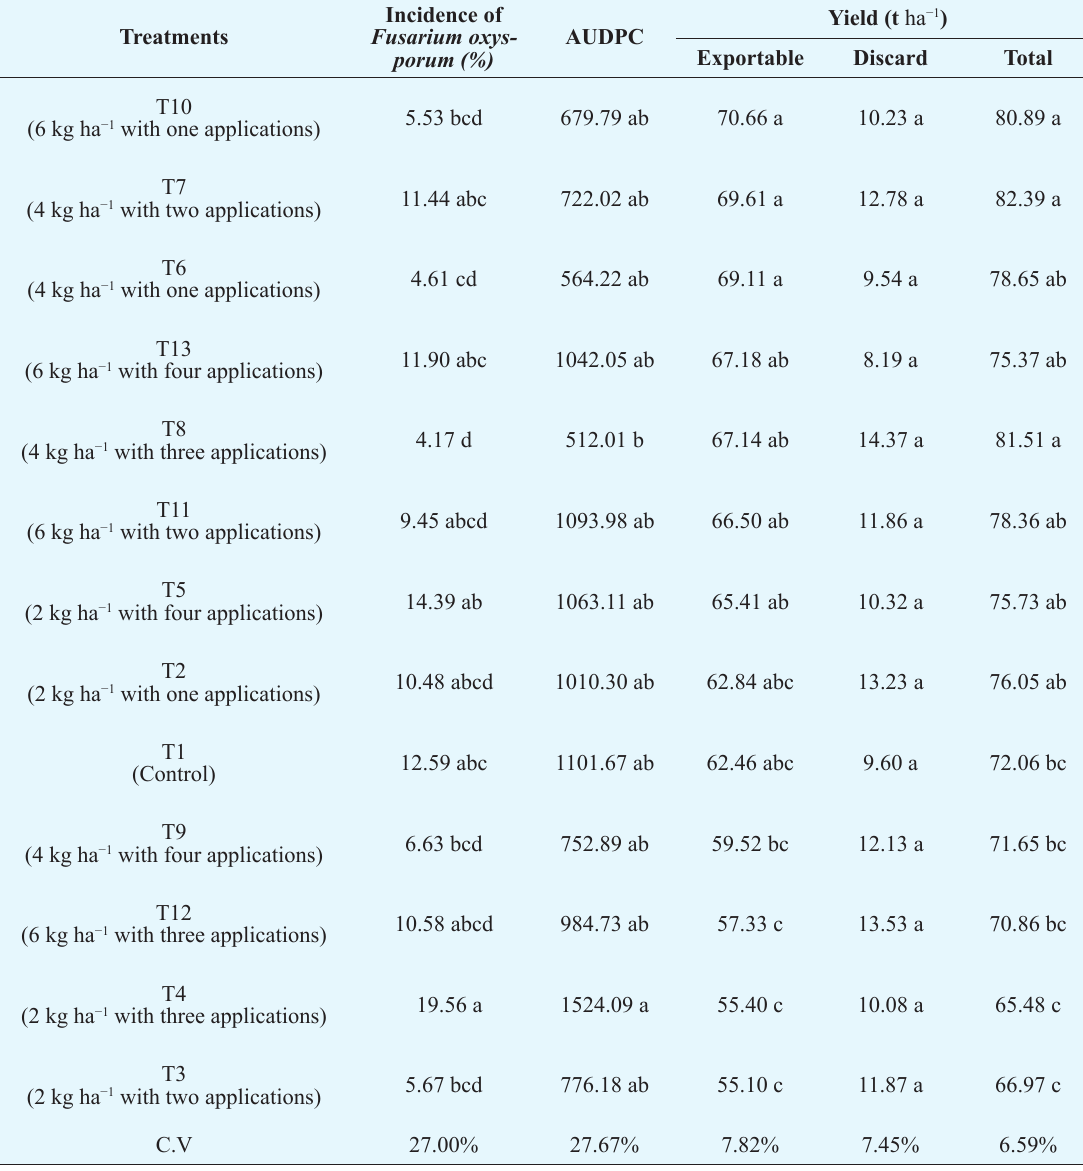
Table 4. Results of the variables evaluated and comparison test of means; Duncan (α =